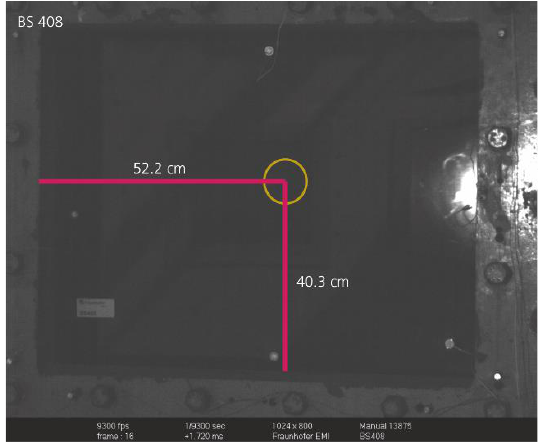
Fig. 6 Visually determined location of initial crack formation using high-speed video recordings (BS 408).